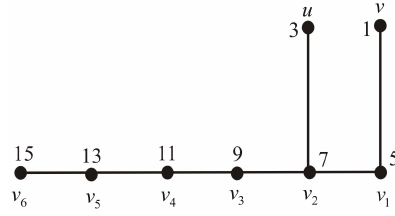
Figure 6: FP n and its odd prime